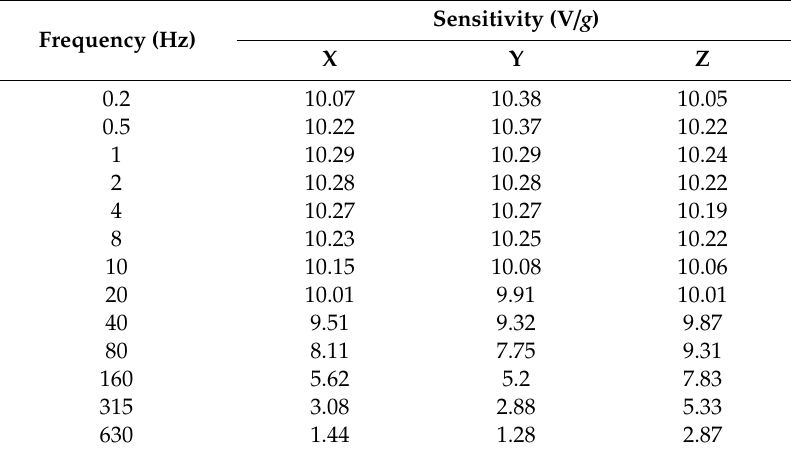
Table 2. The variations of sensitivities with the frequency of the